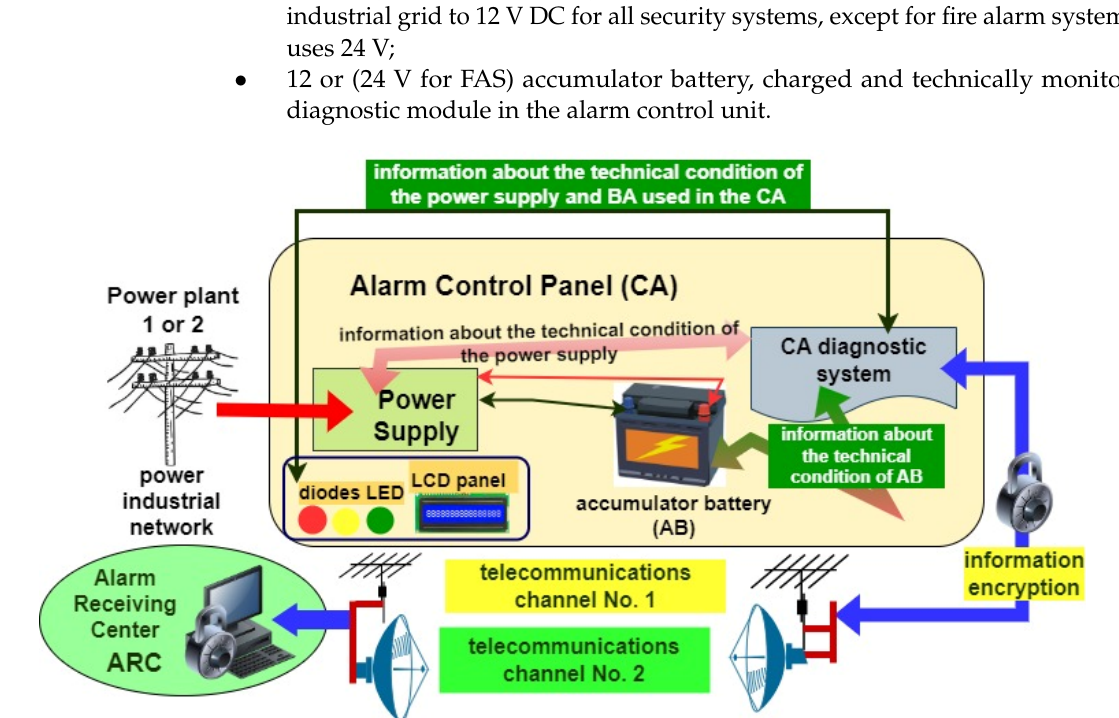
Figure 5. Diagram of a power supply system for an ESS using two independent power sources, a diagnostic subsystem, and two independent telecommunication channels.